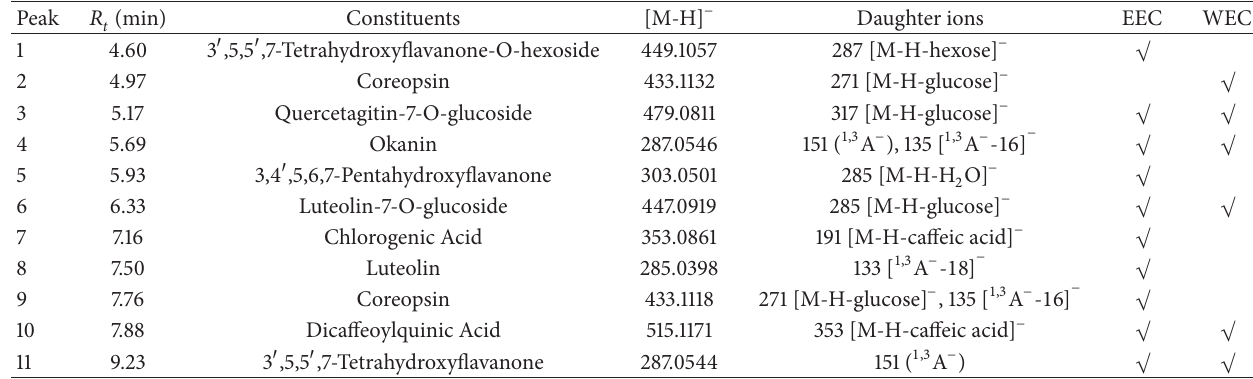
Table 1: Chemical composition in EEC and WEC identified by